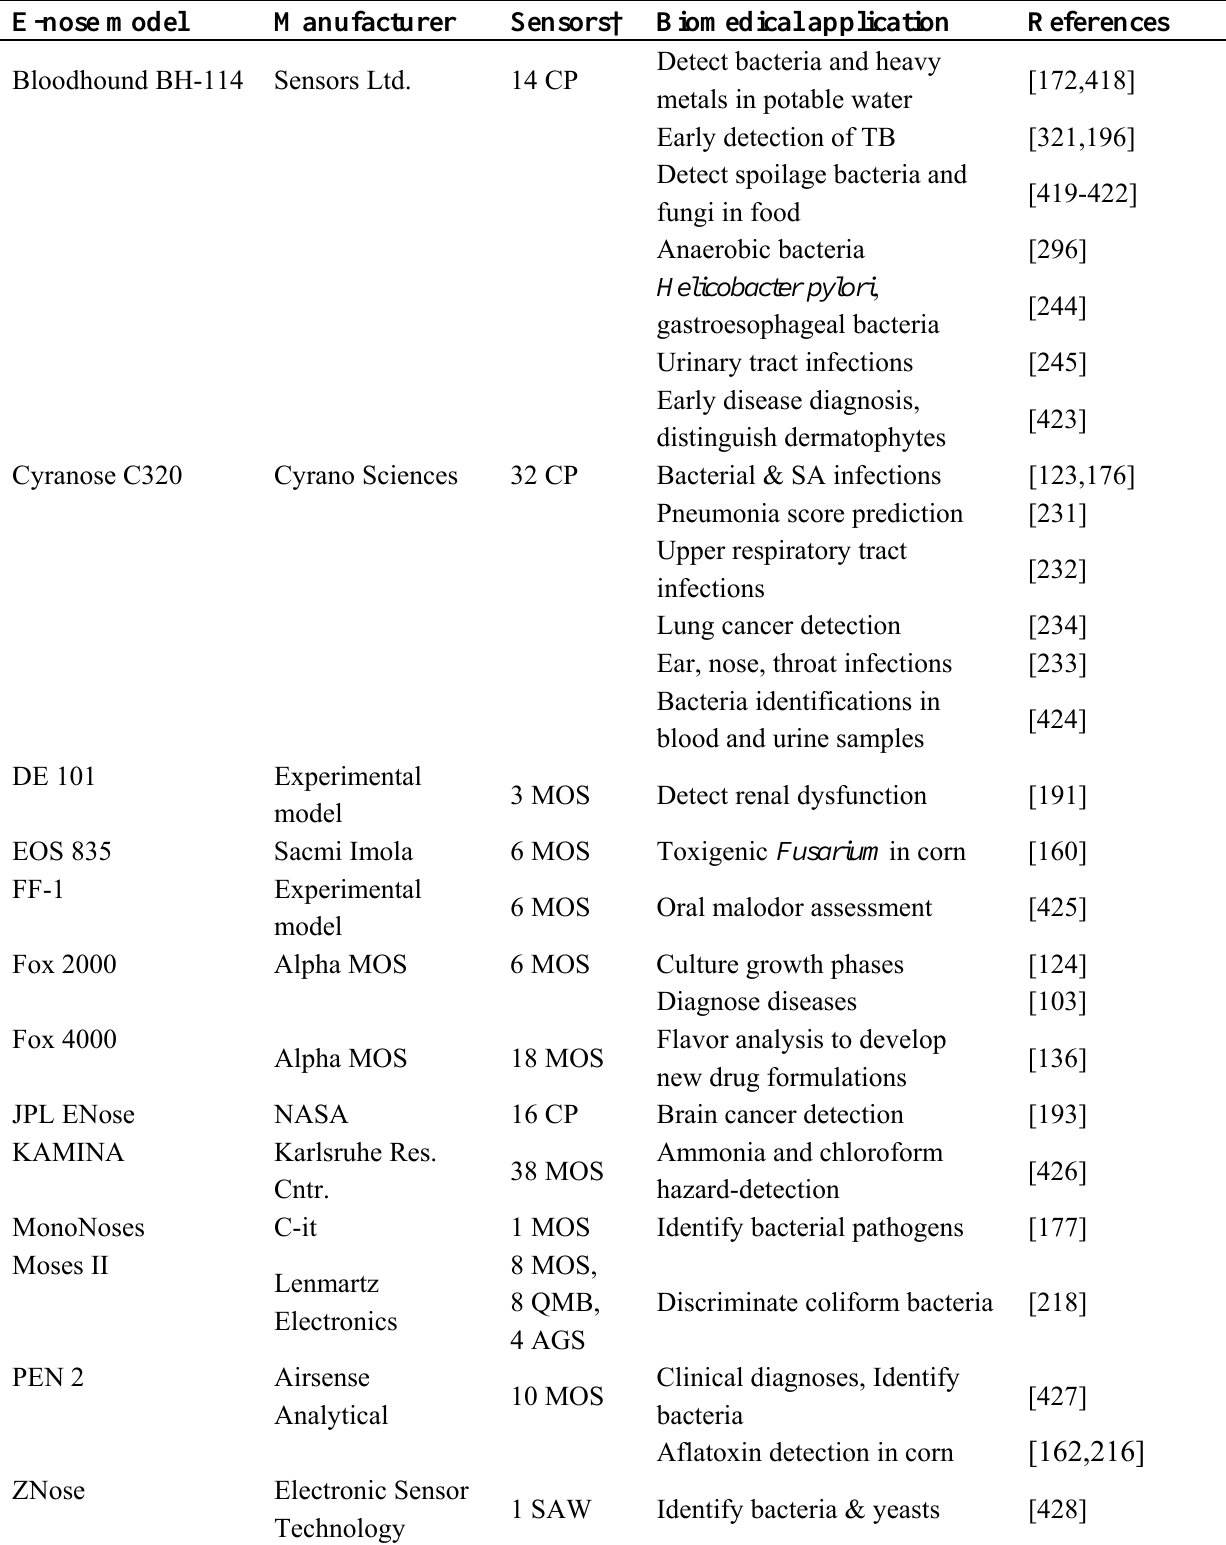
Table 6. Biomedical applications developed using commercial and experimental electronic